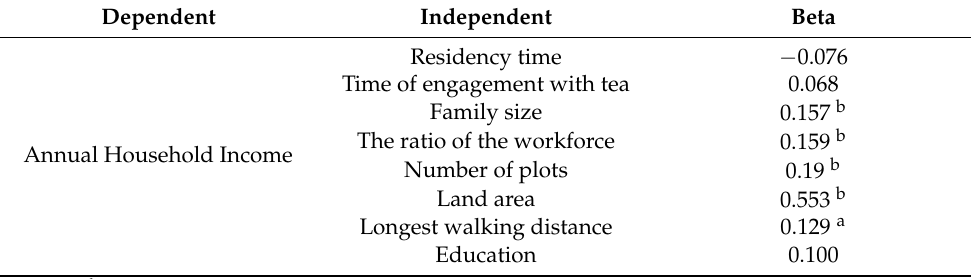
Table 2. Impact on the household income from the analysis of categorical regression (R 2 = 0.611, n = 194).